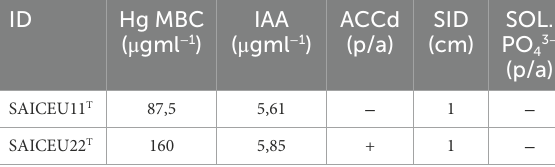
TABLE 1 Hg MBC: Hg maximum bactericidal concentration; IAA: 3-indoleacetic acid production; ACCd: 1-aminocyclopropane-1-